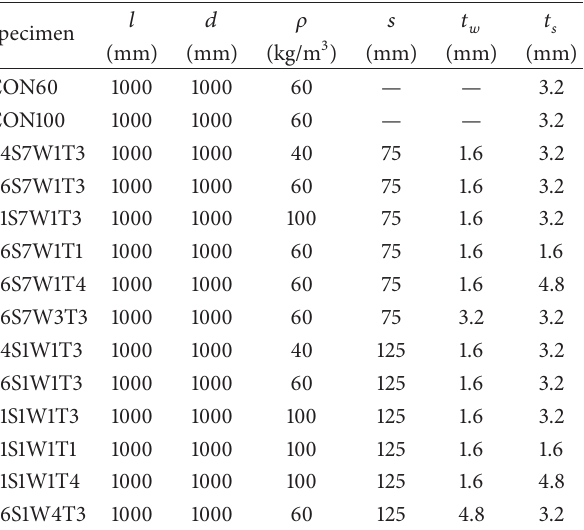
Table 1: Details of specimens.